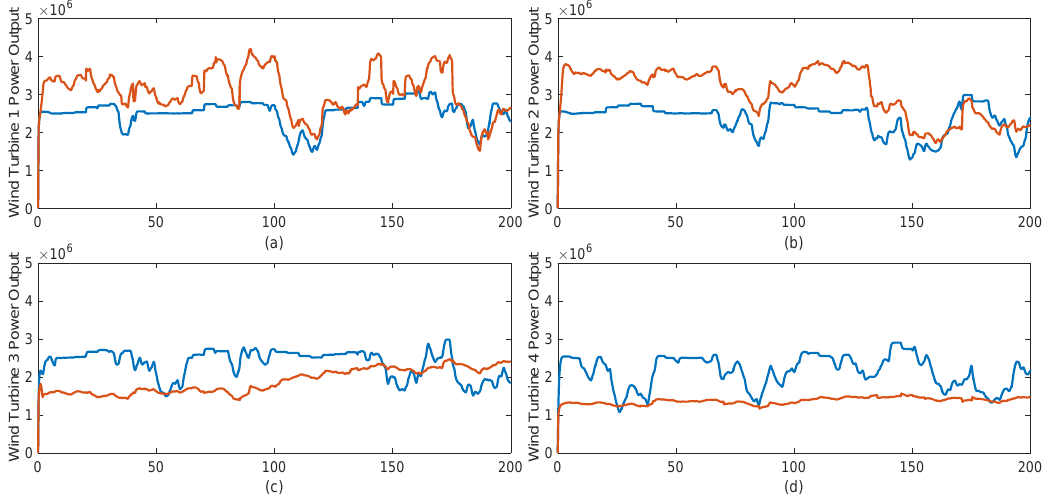
Figure 10. Four-units cluster robustness test—comparison between the proposed strategy and the conventional strategy under varying power demand, sub-figures a, b, c, d are the detailed comparison for wind turbine 1, 2, 3, 4